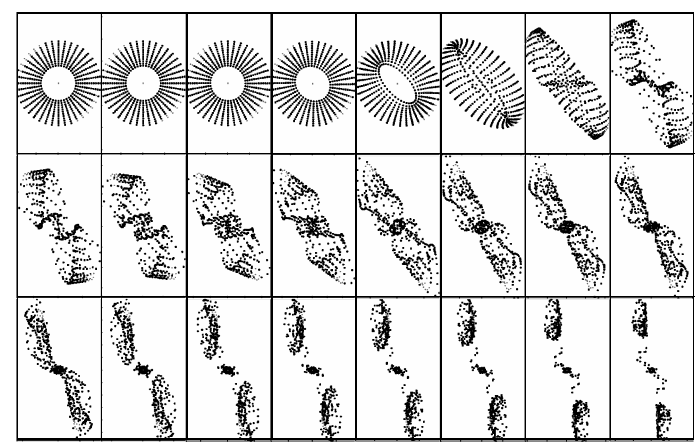
Fig. 4. The case of E = (cid:0) 0 : 75, h = (cid:0) 0 : 5 orbits computed over the time interval (cid:28) = [0 ; 10]. The scale of the x -axis increases from [ (cid:0) 1 : 0; 1 : 0] to [ (cid:0) 10 : 0; 10 : 0].